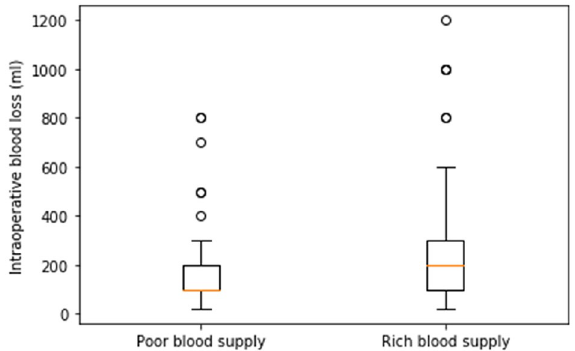
Figure 2. The distribution of intraoperative blood loss in the poor blood supply group and rich blood supply group.